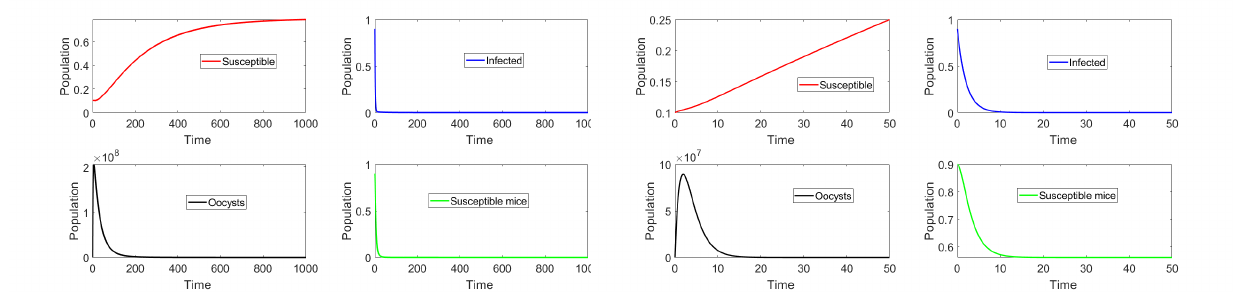
Figure 3. Trajectories of the subpopulations when R 0 = 0.98. The initial subpopulations are distant from the toxoplasmosis-free steady state F ∗ . The left-hand side shows the case in which vaccination is implemented, while the right-hand side shows the case with no vaccination and a larger death/clearance rate µ 0